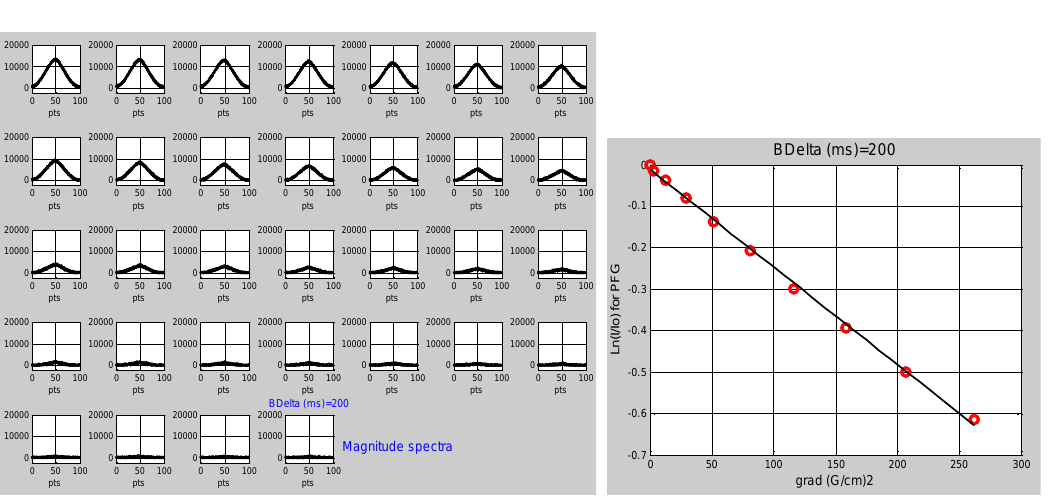
Figure 5. Dependence of echo signals on gradient value in 1D NMR diffusion experiment on spruce piece with water content of 0.8 g H 2 O/g dry matter. MATLAB code was developed (Matrix 7 × 5) to get echo-attenuation value (magnitude with following calculation of integral area) for each gradient step. Wood sample was oriented along X-direction testing for diffusion in tangential direction. The diffusion time Δ = 200 ms. Frequency is 400 MHz, T = 298 K. For left Figure: The intensity (Y-axis) scale is in arbitrary units. X-axis scale is in points.